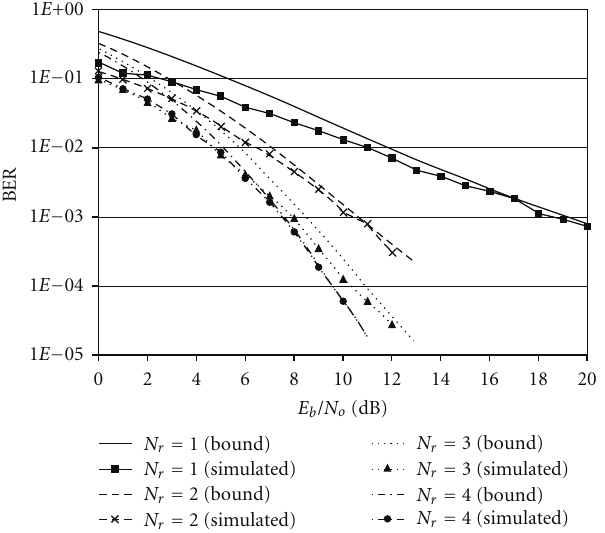
Figure 3: Comparison of BER upper bound to simulated perfor- mance of MIMO-CDMA employing parity-bit-selected spreading for N t = 4 and N r = 1,2,3, and